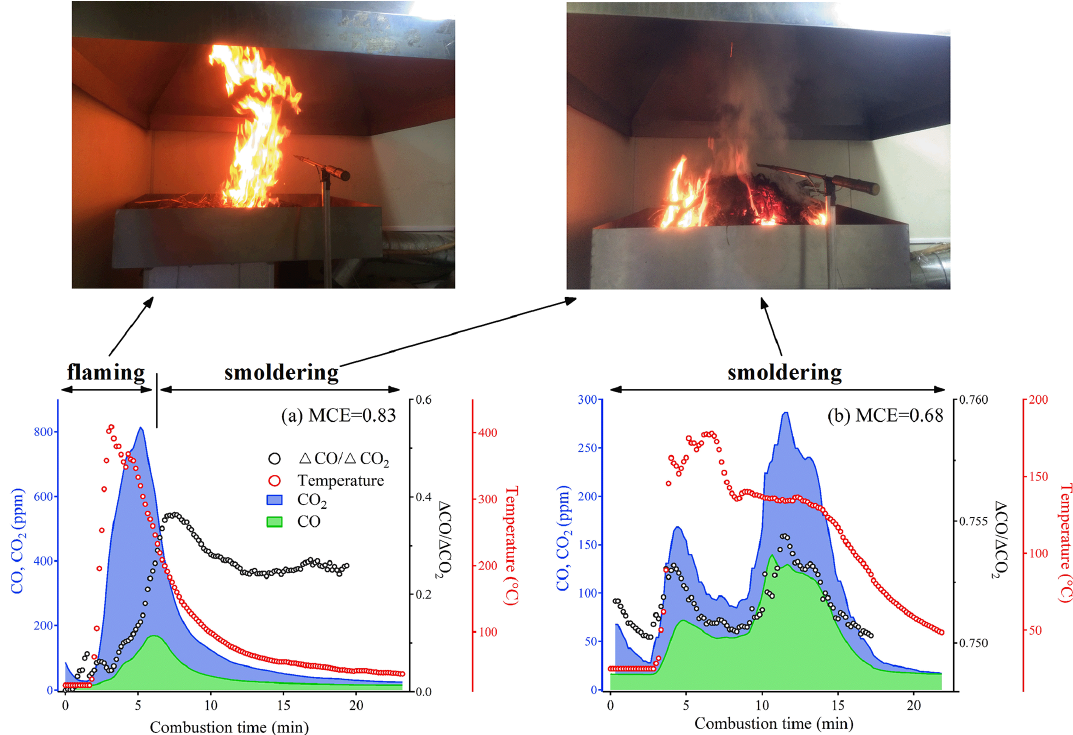
Figure 1. Variations of measured CO and CO 2 concentrations, (cid:49) CO /(cid:49) CO 2 , fire temperatures and burning conditions during two selected experiments, with an averaged MCE value of (a) 0.83 and (b)